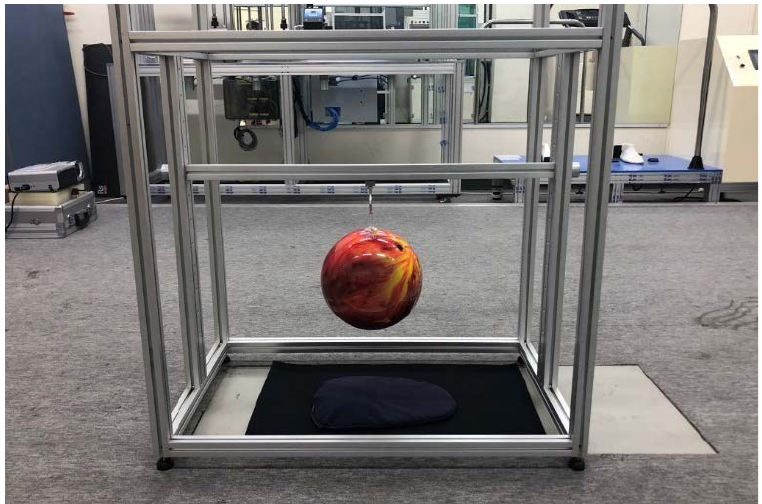
Figure 6. Picture of the impact performance test equipment.